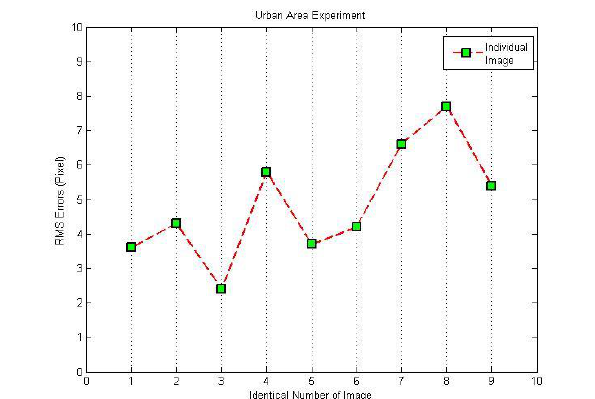
Figure 7. The plot of the RMS errors of the urban test for each